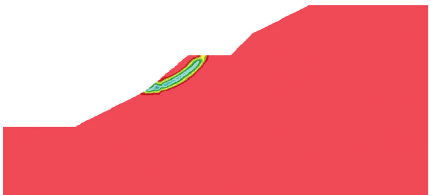
Figure 3: The contour plot of incremental plastic strain magnitude in FLAC with FS � 1.33 (similar to